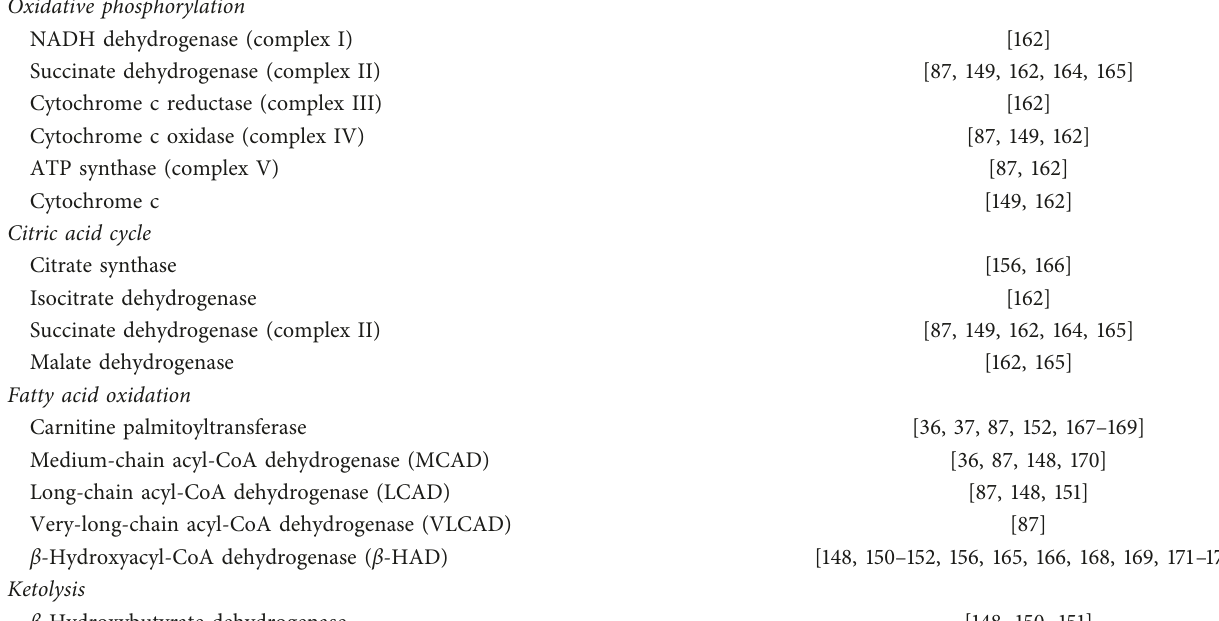
Table 1: Bioenergetic proteins upregulated by ketogenic or low-carbohydrate